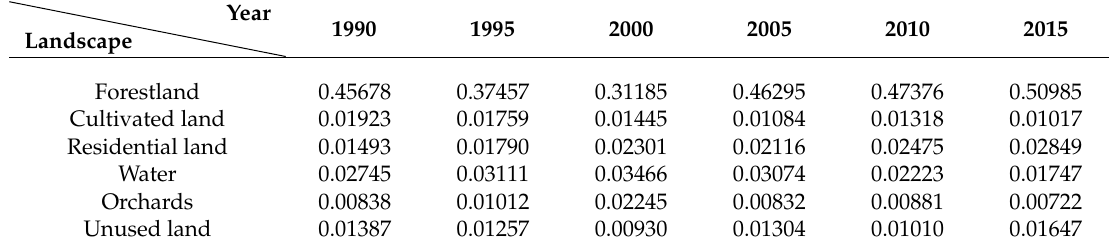
Table 15. Mean patch size (MPS) for various types of landscape (km 2